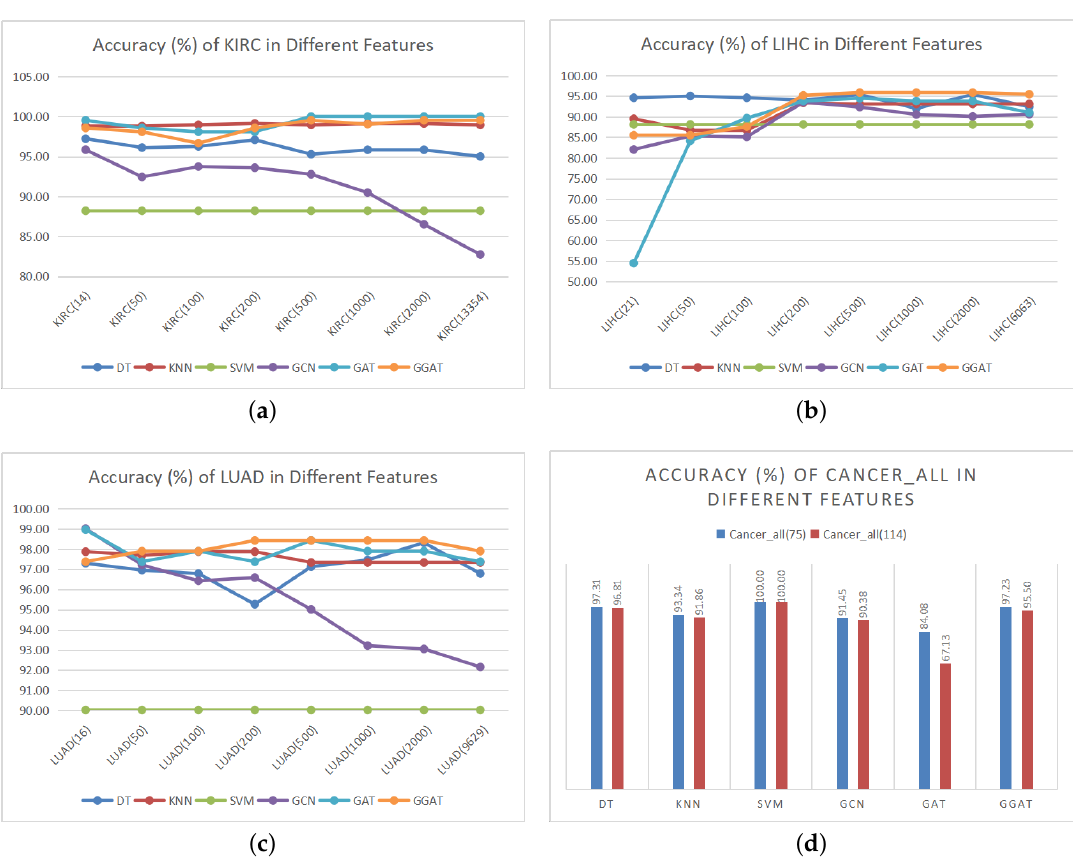
Figure 2. Accuracy (%) of Datasets in Different Features. The digit after the dataset name represents the number of features, the first digit is the optimal feature number selected by our hybrid feature selection algorithm, the last digit is the original feature number before exact